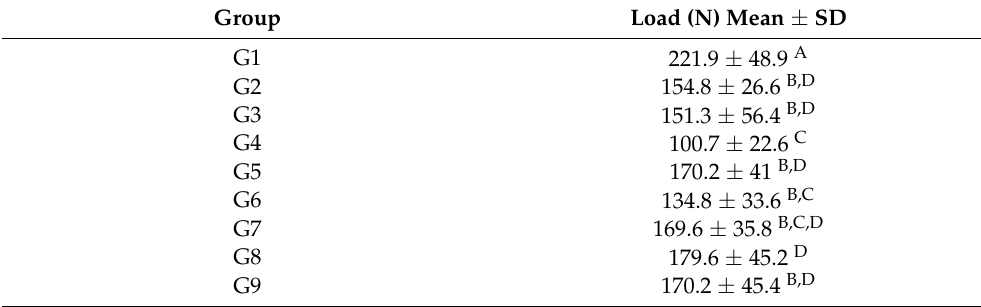
Table 2. Fracture load (N) of different groups.